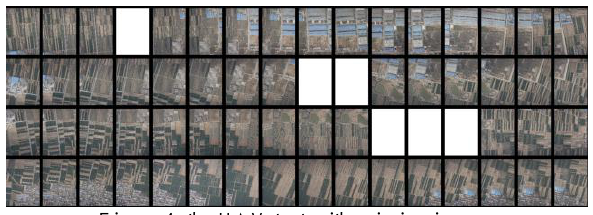
Figure 4. the UAV test with missing